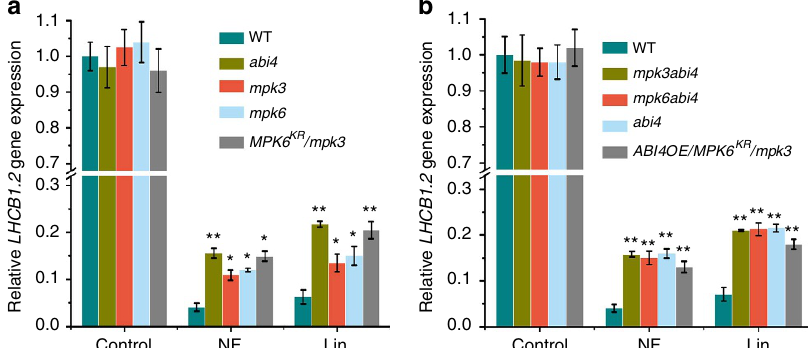
Figure 4 | ABI4 genetically interacts with MPK3 and MPK6 in the retrograde response. ( a ) Impact of Lin and NF treatments on LHCB1.2 transcript levels in wild type(WT), abi4 , mpk3 , mpk6 and MPK6 KR mpk3 . Arabidopsis seedlings were grown on 1/2 MS medium containing 500 m M Lin or 5 m M NF and harvested 7 days later. RNA was extracted and transcript levels of LHCB were analysed by qRT–PCR. ( b ) Impact of Lin and NF treatments on LHCB1.2 transcript levels in WT, abi4mpk3 , abi4mpk6 , abi4 , ABI4OE and ABI4OE/MPK6 KR /mpk3 . Arabidopsis seedlings were grown on 1/2 MS medium containing 500 m M Lin or 5 m M NF and harvested 7 days later. RNA was extracted and the levels of LHCB mRNA were analysed by qRT–PCR. The relative transcript level of LHCB in seedlings grown on Lin or NF medium were normalized to values of control seedlings grown on 1/2 MS medium. The mean ± s.d. of three biological replicates is shown. Asterisks indicate significant differences from WT (* P o 0.05 or ** P o 0.01, Student’s t -test). NATURE COMMUNICATIONS|7:12173|DOI: